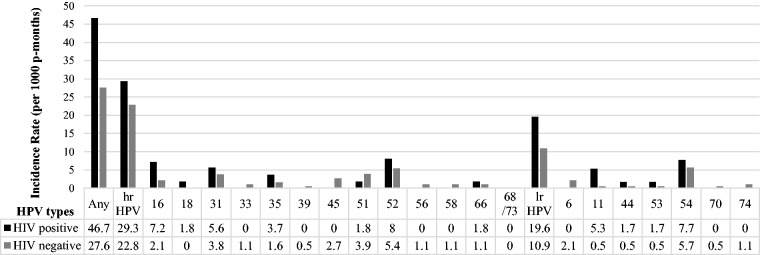
IRs of any HPV, hrHPV and lrHPV, among 160 FSWs with 12 or more months of follow-up, Nairobi, Kenya. hrHPV: high-risk HPV; lrHPV: low-risk HPV.